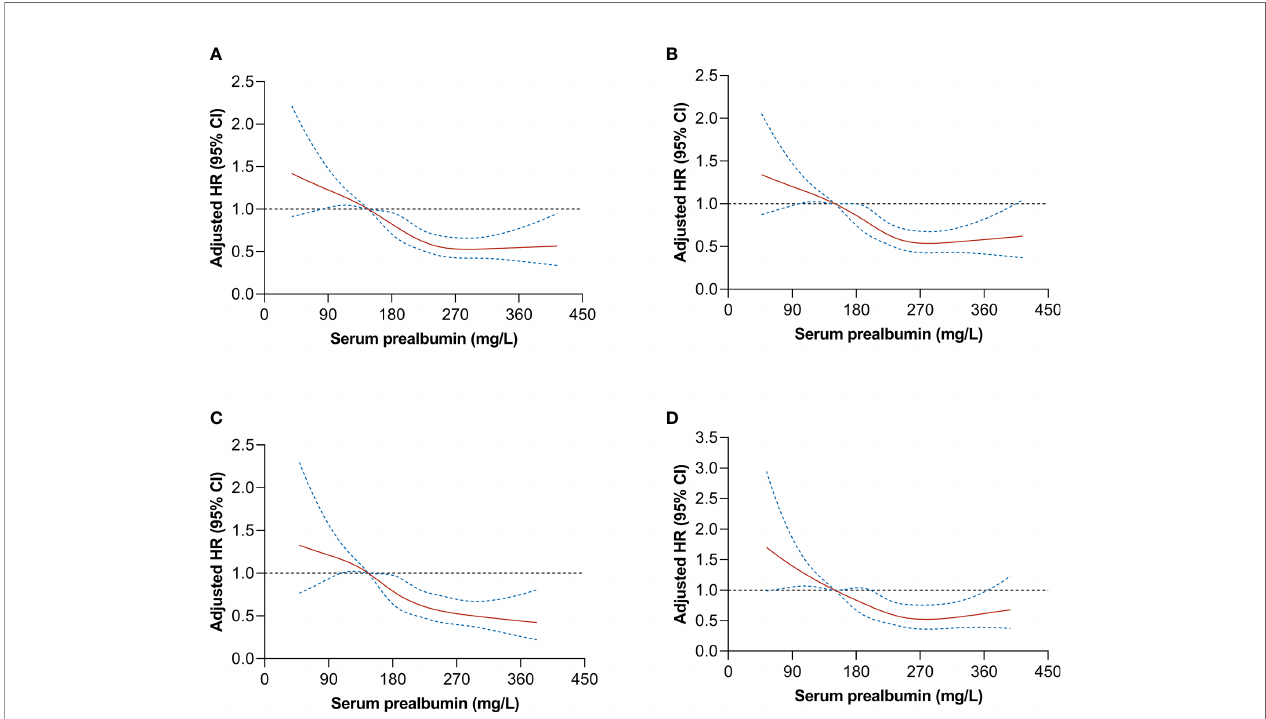
FIGURE 1 | | Dose – response relationship between serum prealbumin and the risk of mortality after hepatectomy in patients with hepatocellular carcinoma. Graphs show the hazard ratio (HR; solid red lines ) and 95% con fi dence interval (CI, dotted blue lines ) describing the association of serum prealbumin with the risk of mortality. Cox regression analysis with a restricted cubic spline approach was conducted to allow fl exible, non-linear assessment of the HR for mortality in (A) all patients (n = 2,022), (B) patients with overall survival >3 months (n = 1,883), (C) patients with liver cirrhosis (n = 1,159), or (D) patients without liver cirrhosis (n = 863) (all P < 0.001). All models were adjusted for age, sex, HBsAg, liver cirrhosis, tumor size and number, tumor capsule, AFP, ALB, ALT, AST, TBIL, Child- Pugh, and BCLC stage.